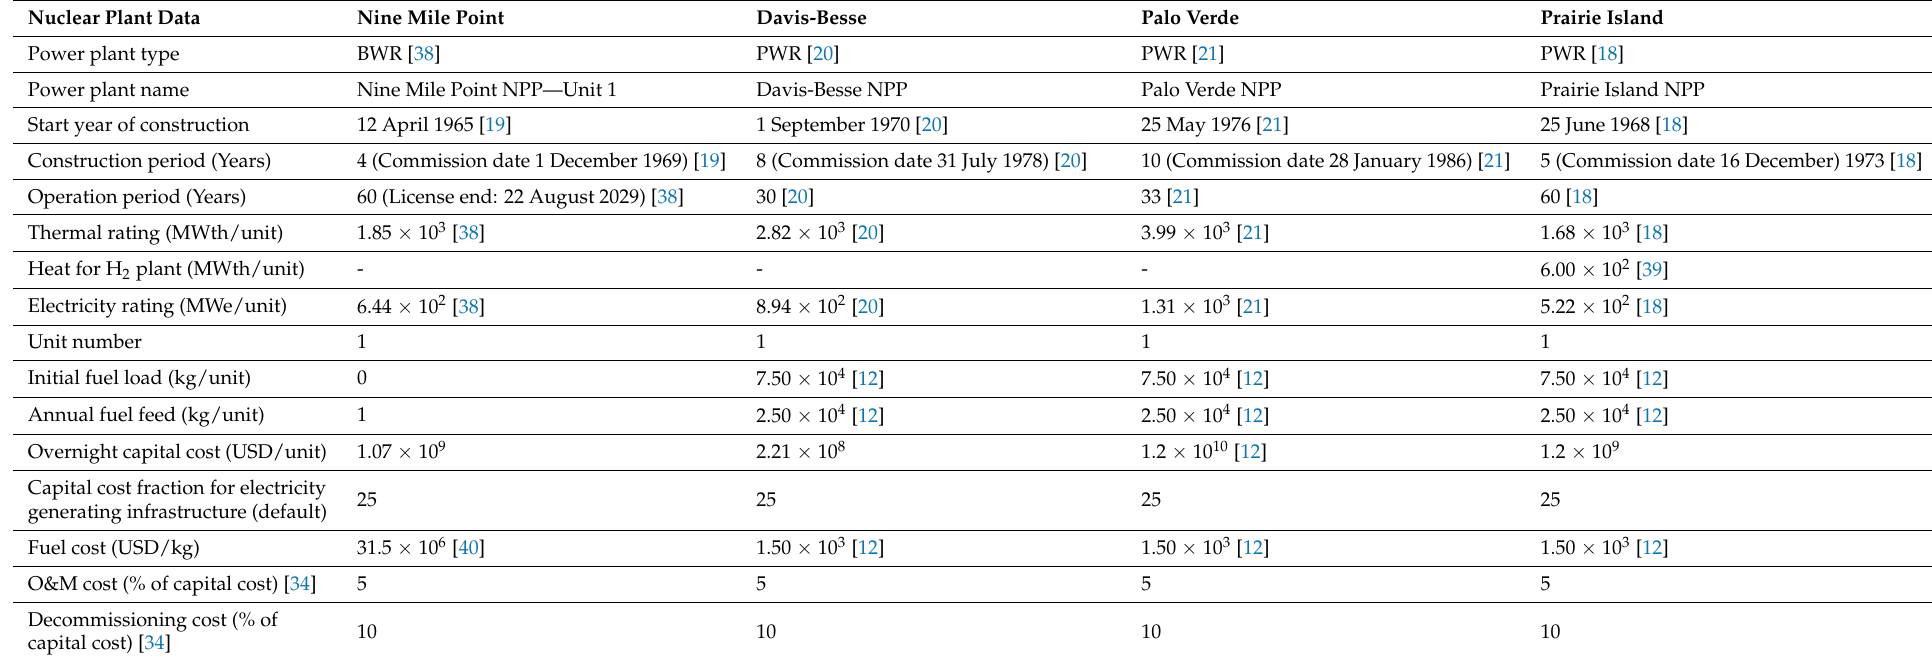
Table 2. Nuclear power plant input data for estimation of the hydrogen-production